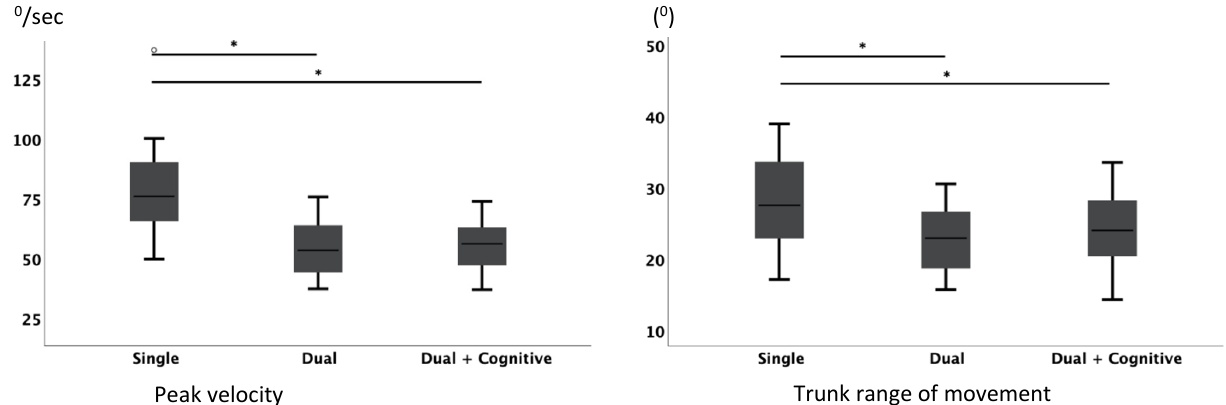
Figure 3. Sit-to-stand parameters for the three conditions: single task, dual task, and dual and cognitive task during the ITUG test. * Significant differences for pairwise